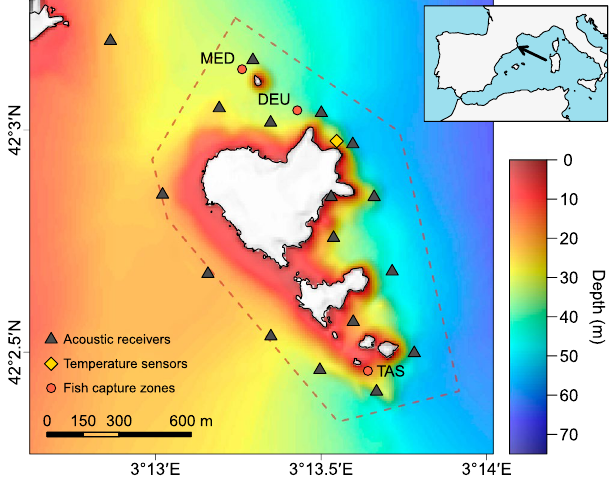
Figure 1. Bathymetric map of the study site and the location of acoustic receivers and temperature sensors. The approximate locations where the common dentex individuals were captured are also shown (see Table 1). In situ temperature sensors were placed every 5 m (between 5–40 m) in the marked location. Map was created using R 60 version 3.3.1 (https://cran.r-project.org). The topographic base map (1:5.000), DEM and bathymetry are freely accessible through the Cartographic and Geologic Institute of Catalonia (www.icgc.cat) under Creative Commons Attribution License (CC BY 4.0).